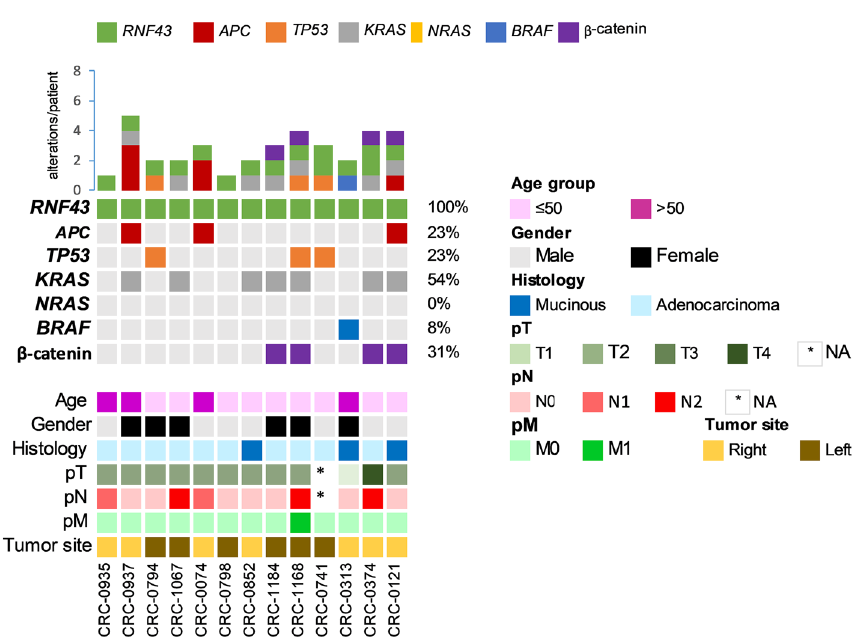
Figure 3. Mutations in known driver genes along with β-catenin expression in RNF43 positive cases (n = 13). The top panel displays the number of mutations identified across tumors, whereas the right panel show the proportion of mutations/gene across each group. Clinical details are included for each patient.